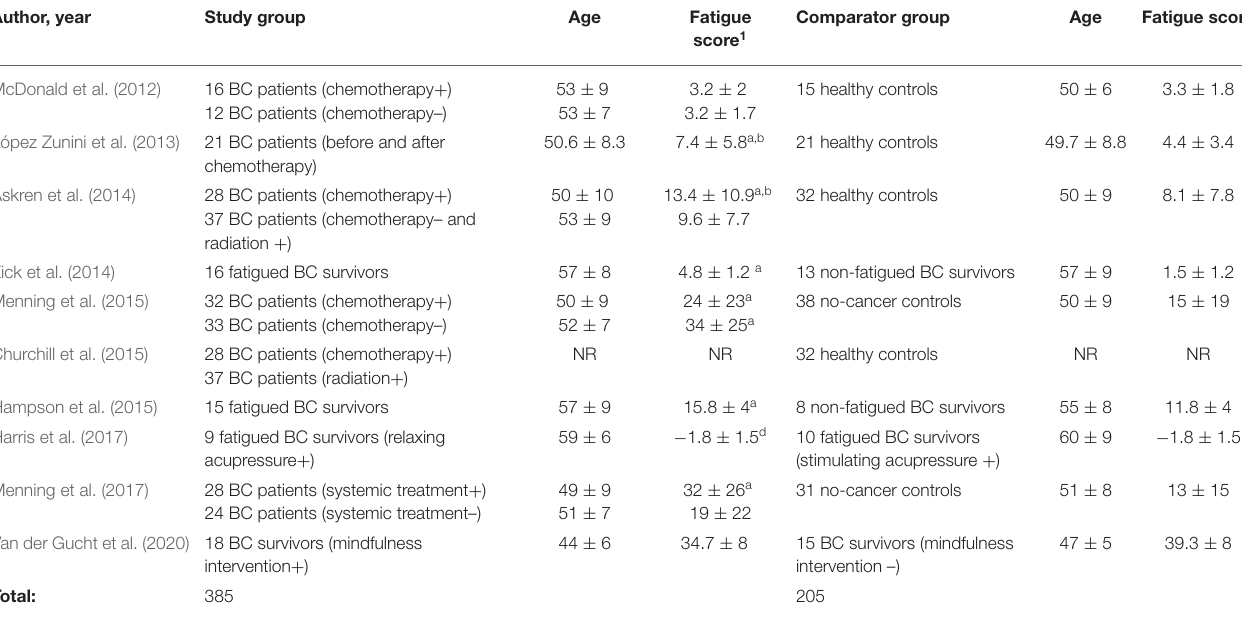
TABLE 2 | Population of breast cancer patients and survivors investigated for neural mechanisms of breast cancer related fatigue. Author,